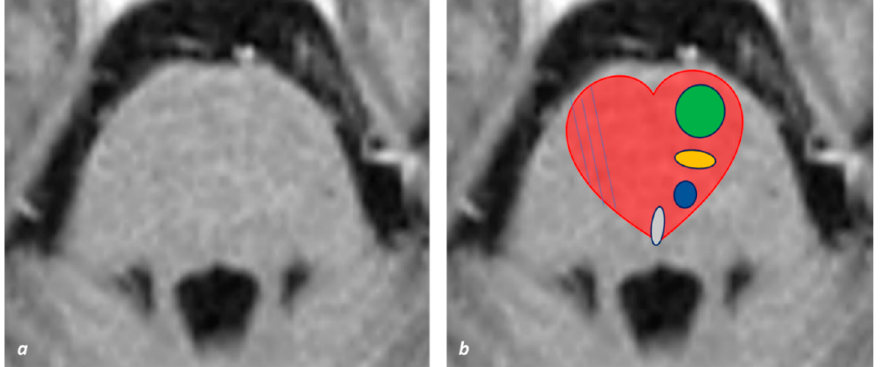
Figure 6. Schematic view of pontine structures involved in the heart appearance sign. (a) Lower pontine axial section (T1W MRI). (b) Corresponding redesigned picture in (b) with the superim- posed red heart sign. Arterial supply is depicted in red for paramedian branches, red with blue lines for anterolateral branches and white for long circumferential arteries. On the right half of the heart are depicted the corticospinal tract (green), the medial lemniscus (yellow), the central tegmental bundle (blue) and the medial longitudinal fasciculus (violet).